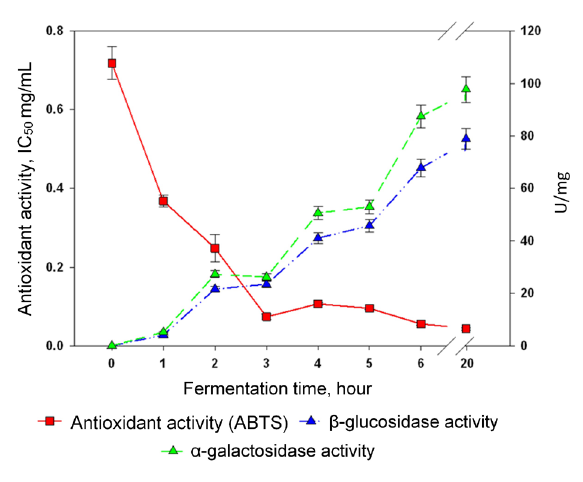
Fig. 3. α -galactosidase, β -glucosidase, and antioxidant activity dynamics of fermented